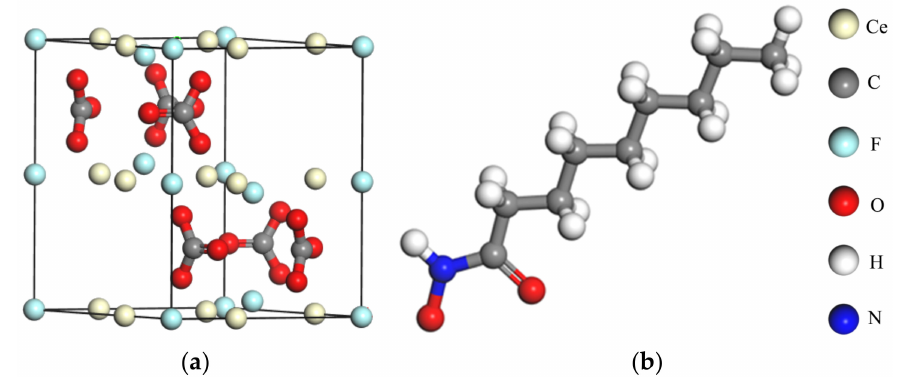
Figure 1. ( a ) Unit cell of bastnaesite and ( b ) the molecular model of NHA - .